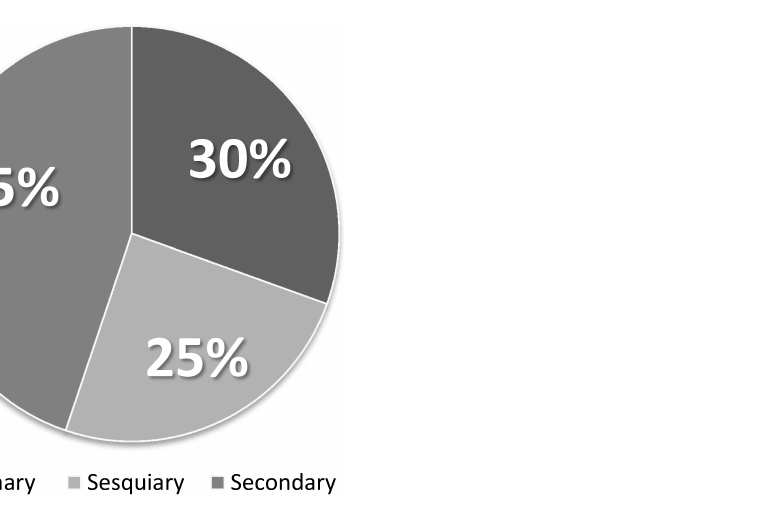
Figure 4. A breakdown of classification of the additional Earthquake tweets according to the origi- nal criteria.